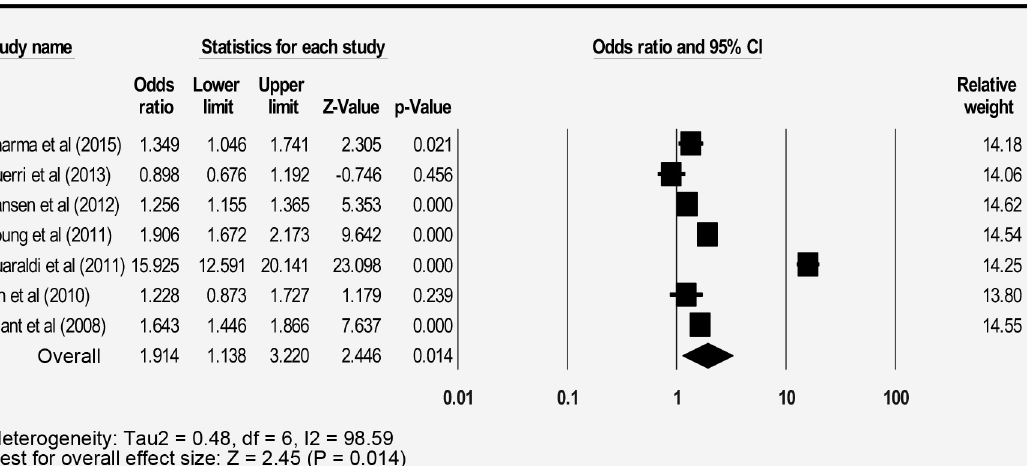
Fig 2. Forest plot for fracture odds ratio between PLWH and general